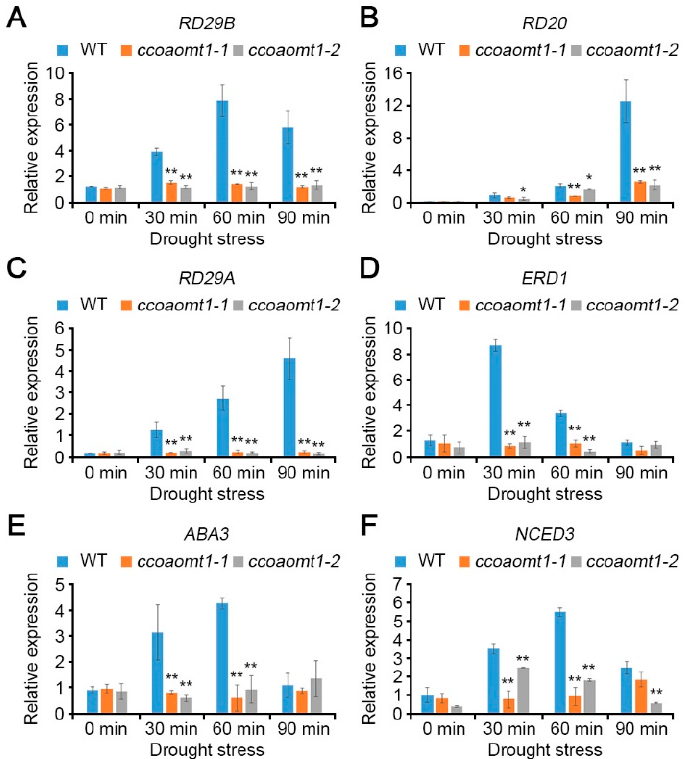
Figure 5. The mutation in CCoAOMT1 gene affected the expression of ABA biosynthesis genes during drought stress. The relative transcript levels of RD29B ( A ), RD20 ( B ), RD29A ( C ), ERD1 ( D ), ABA3 ( E ), and NCED3 ( F ) were analyzed in WT and ccoaomt1 mutants ( ccoaomt1-1 and ccoaomt1-2 ) using qRT-PCR. Total RNAs were extracted from 10-day-old seedlings treated with drought stress for 0, 30, 60, and 90 min, respectively. Expression of genes was normalized to that of TUBULIN2 . Bars represent mean ± SD of three biological replicates with three technical replicates each. Asterisks represent significant differences from the WT (*, p < 0.05; **, p < 0.01; Student’s t -test).